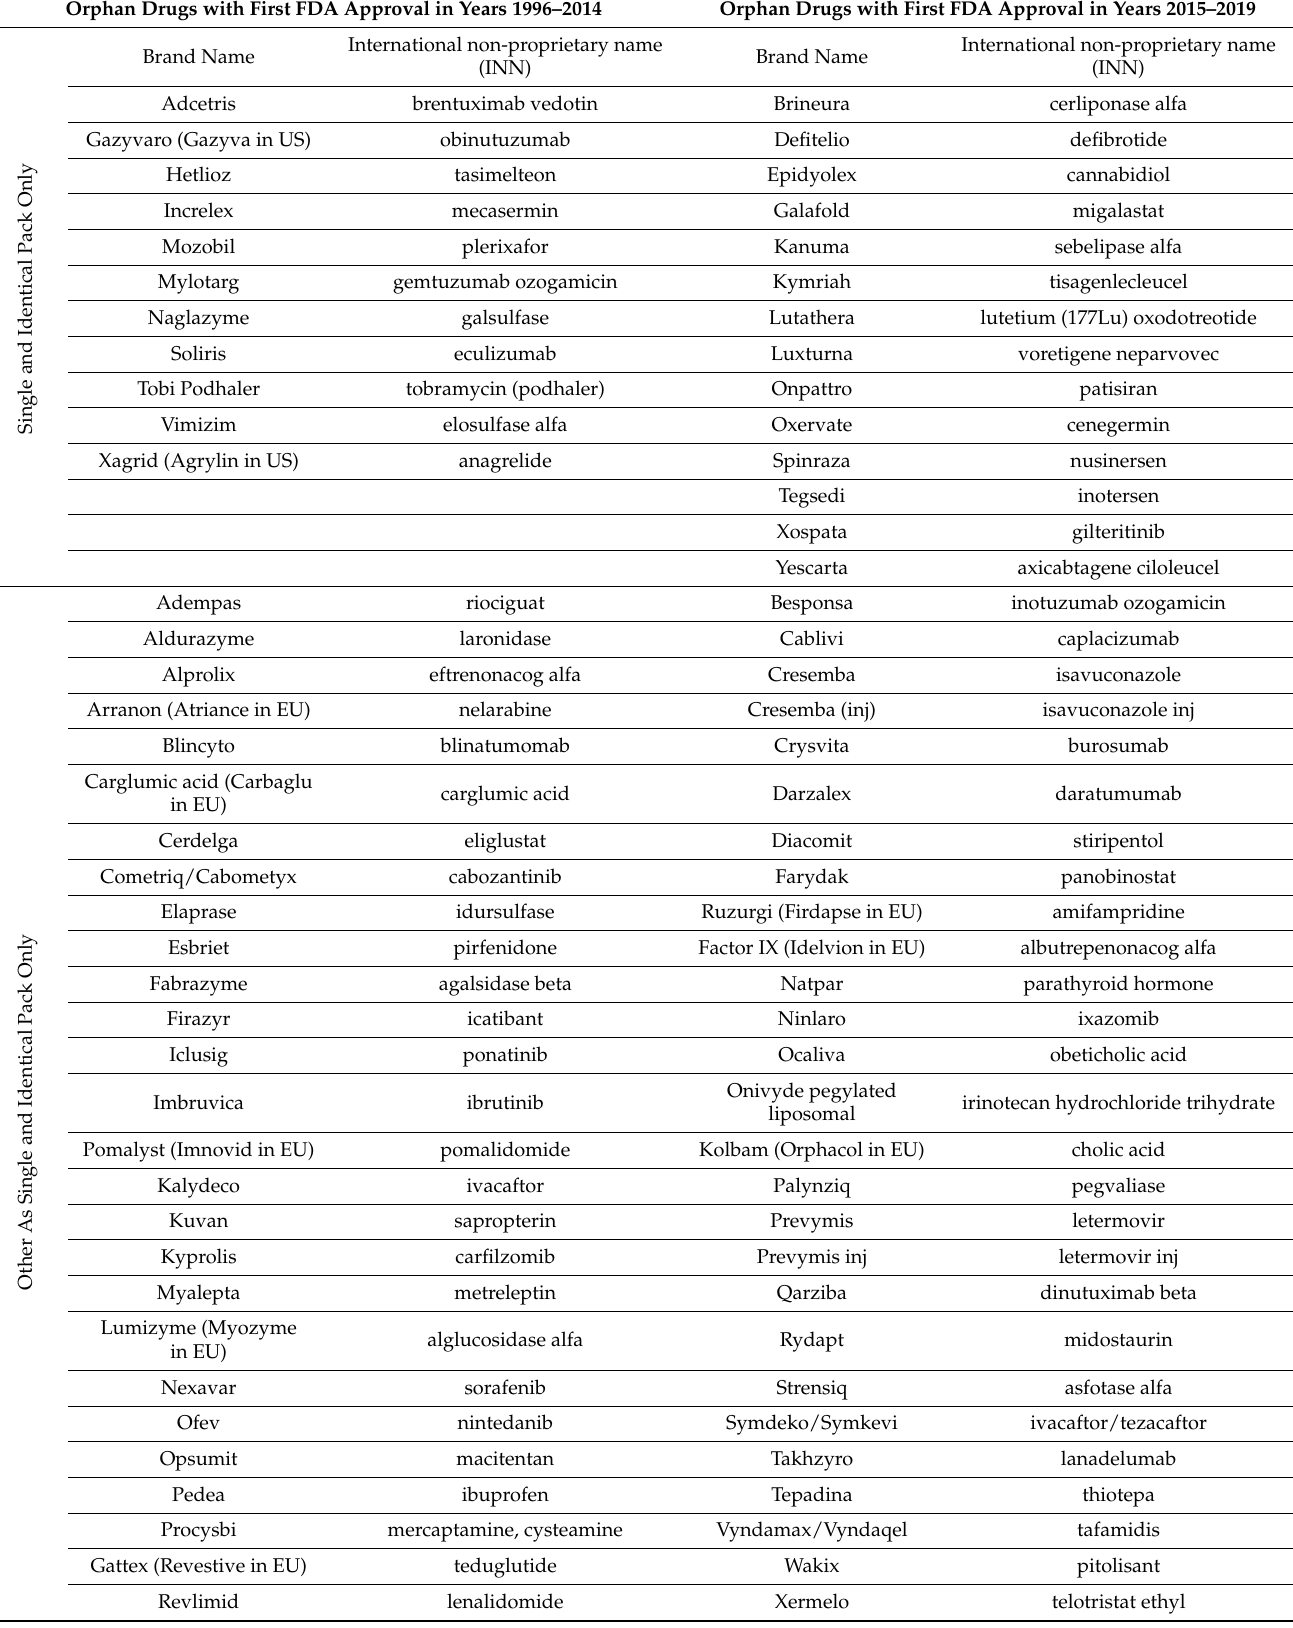
Table 1. Orphan Drugs Analysis—used segmentation. US vs. 6 EU